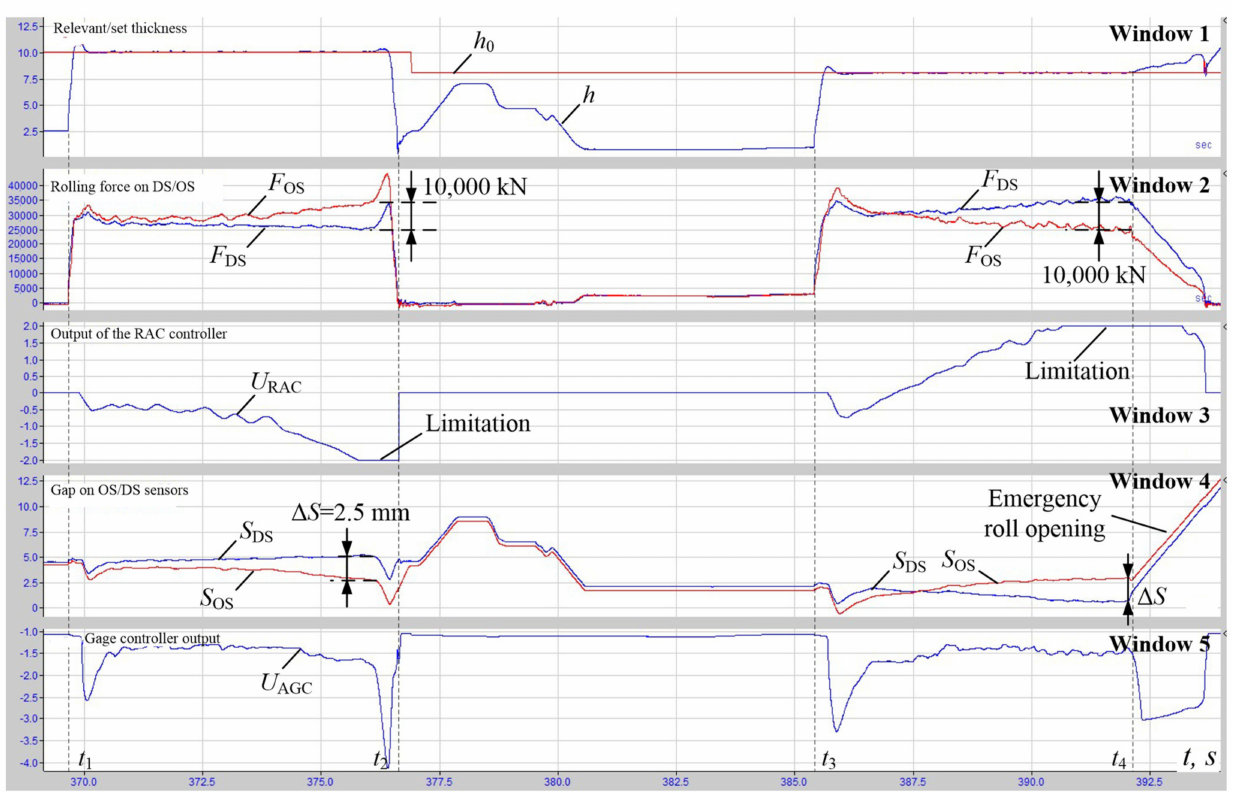
Figure 6. Oscillograph record at design setting of the RAC